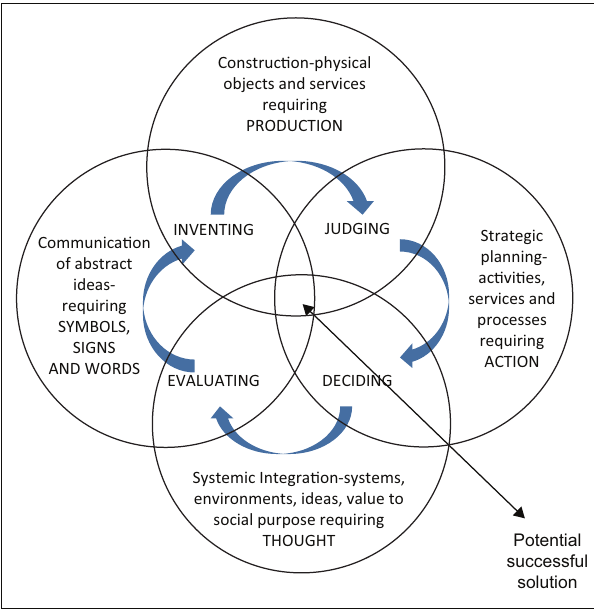
FIGURE 1: Problem placement